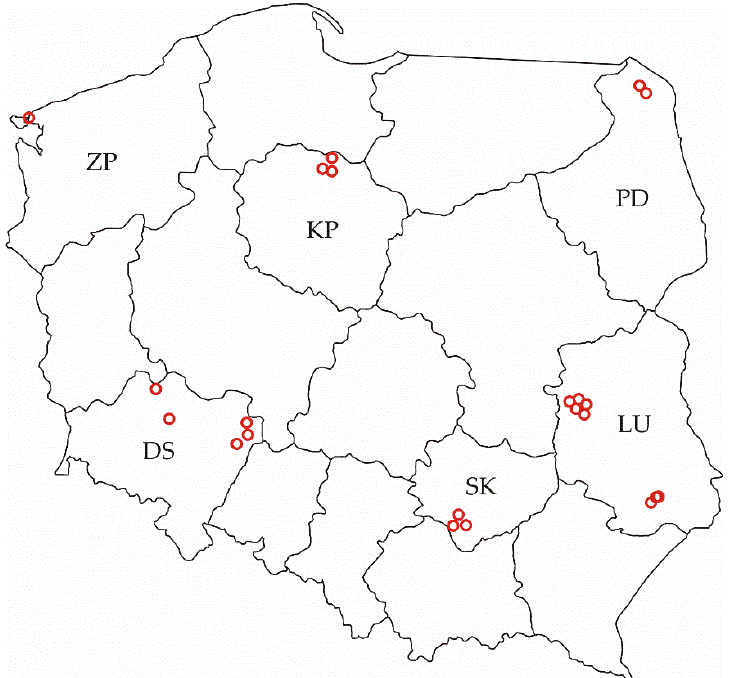
Figure 1. Map of 27 sampling sites included in this survey and located in six provinces in Poland: Zachodniopomorskie (ZP), Kujawsko-Pomorskie (KP), Podlaskie (PD), Dolno´sl ˛askie (DS), ´Swi˛etorzyskie (SK) and Lubelskie (LU). Circles indicating closely located sampling sites overlap in some provinces. For the number of sampling sites see Table